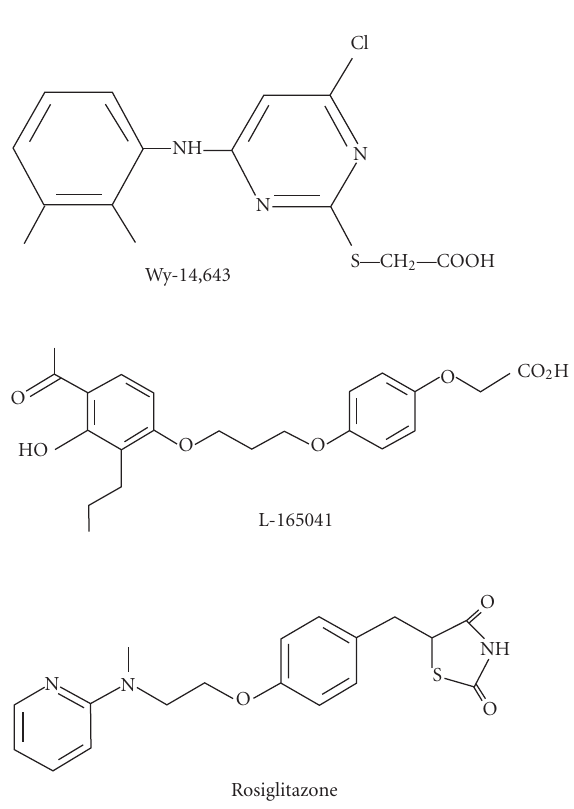
Figure 1. Chemical structures of representative PPAR agonists. PPAR α : Wy-14,643, PPAR β/δ : L-165041, and PPAR γ : Rosiglita-